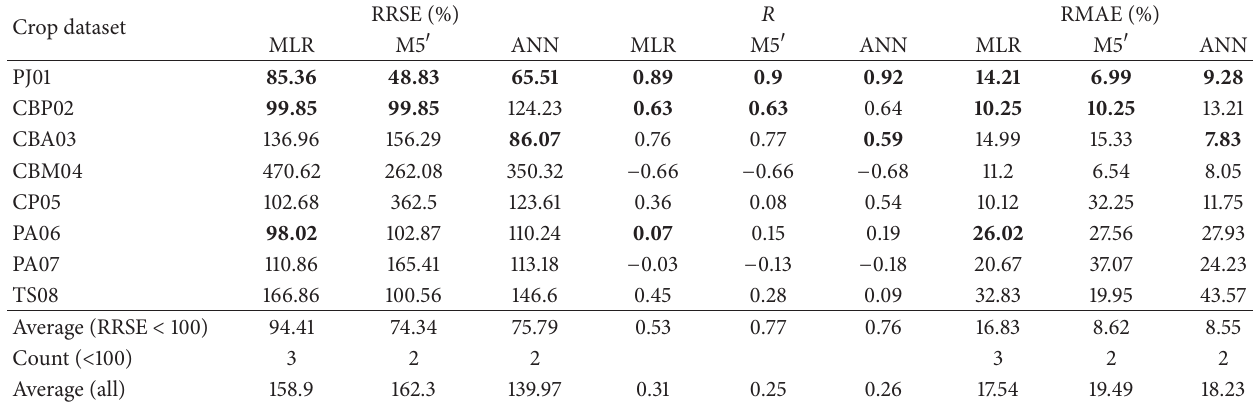
Table 6: RRSE, 𝑅 , and RMAE measures using all the potential attributes.